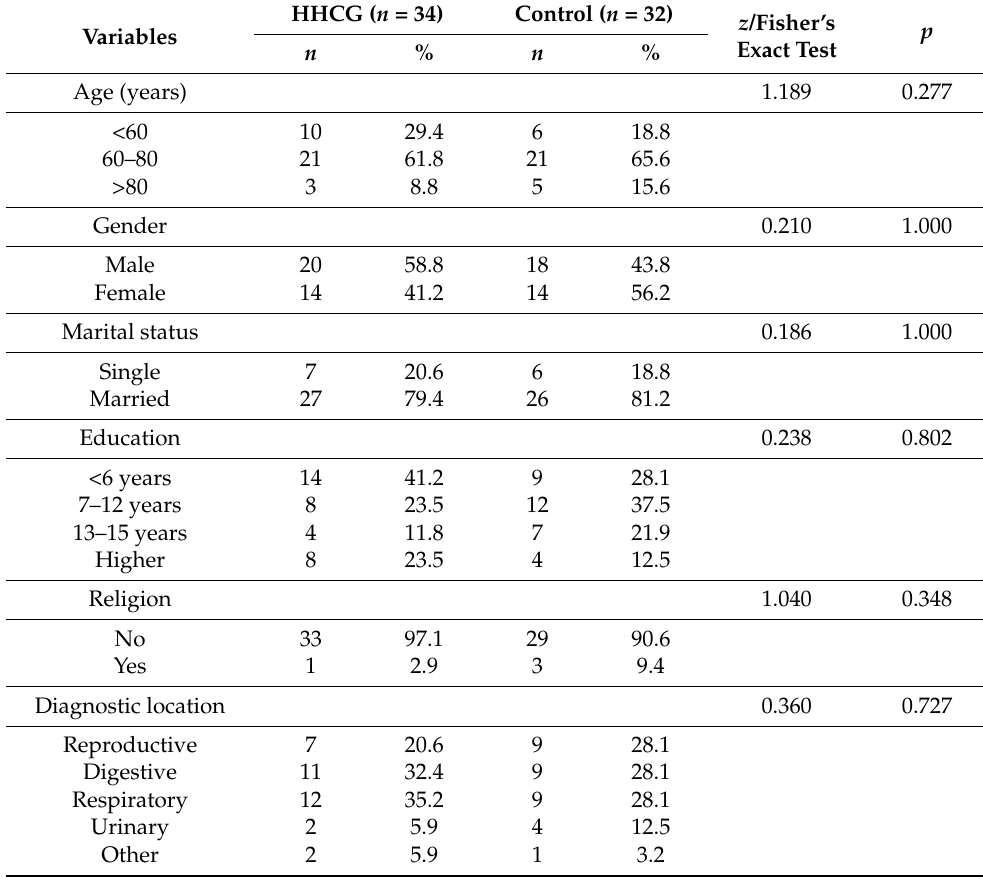
Table 1. Demographic and clinical characteristics ( N =